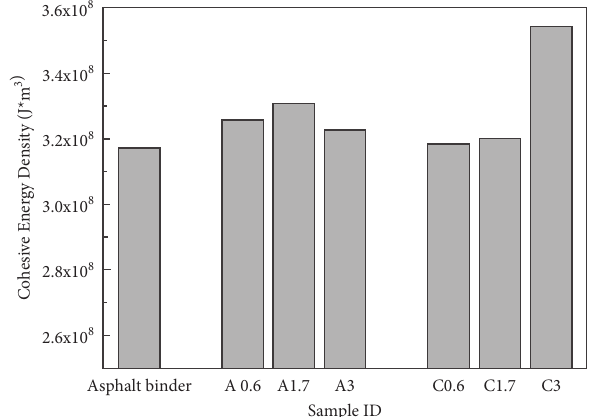
Figure 7: The CED results of different